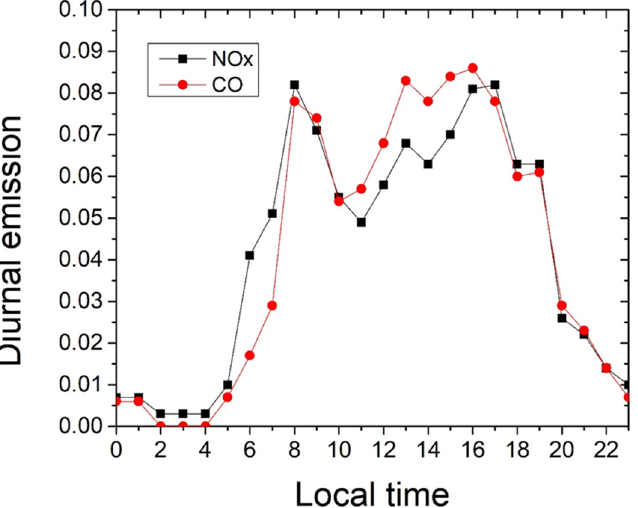
Figure 4. Hourly emissions profile for NOx and CO for each grid cell in the weather research and forecasting model coupled with chemistry (WRF-Chem) model used in this study. forecasting model coupled with chemistry (WRF-Chem) model used in this